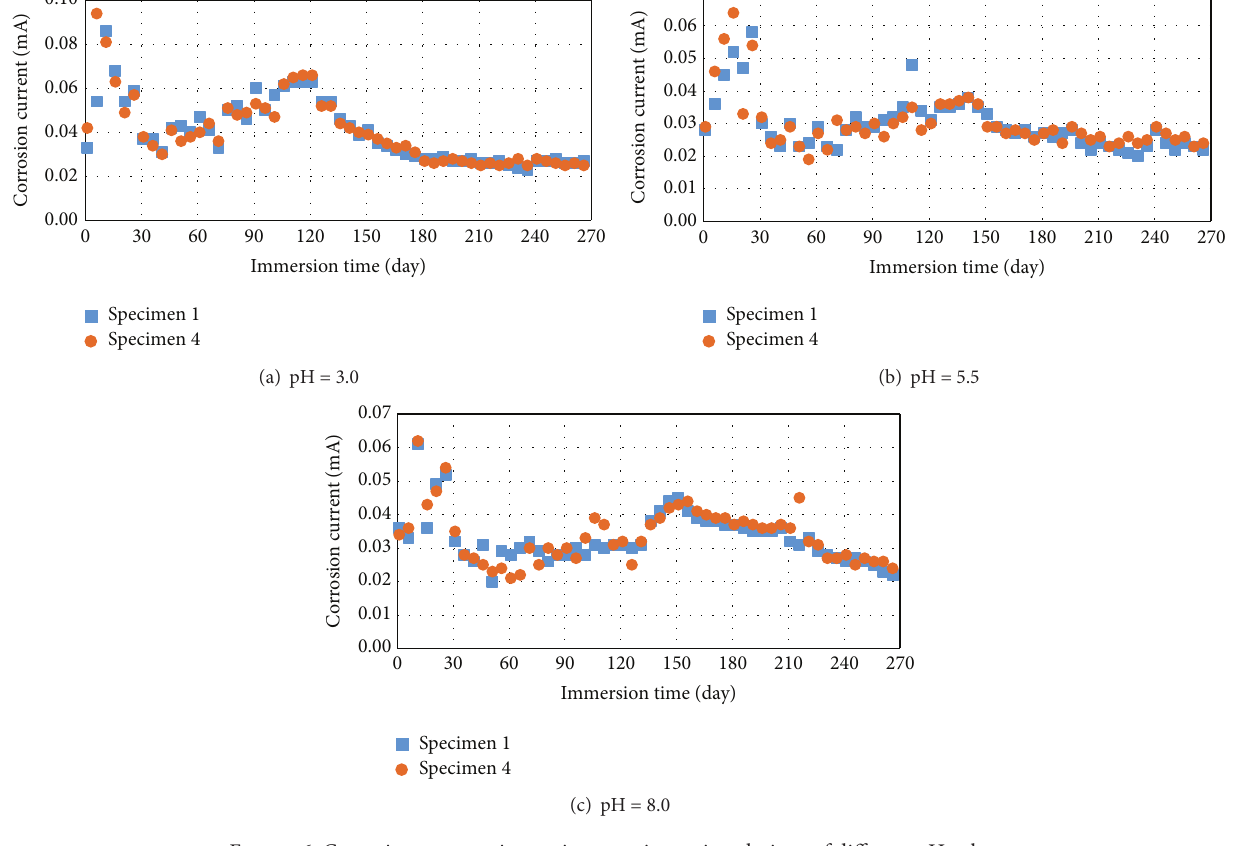
Figure 6: Corrosion currents in cast iron specimens in solutions of different pH